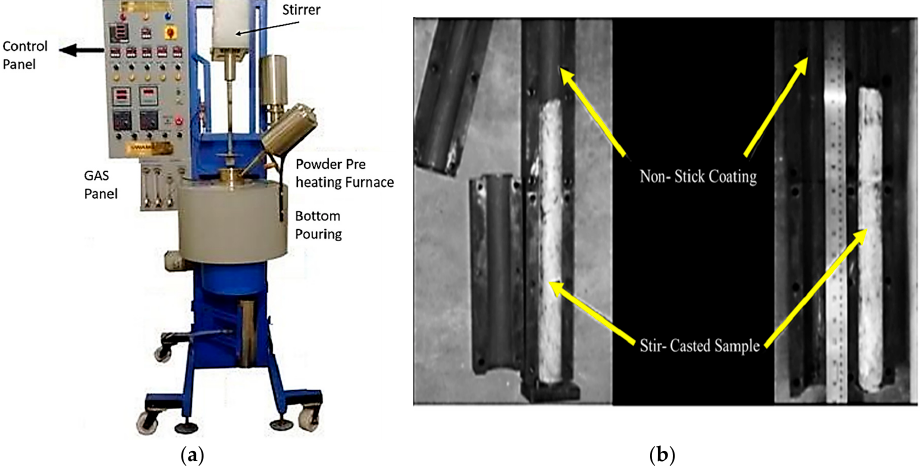
Figure 1. Die-casting furnace diagram—Preparation of casting: ( a ) Stir-casting machine, ( b ) Stir-casted sample.